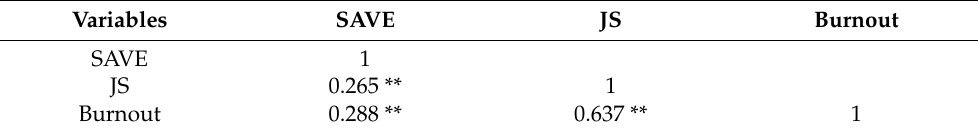
Table 3. Correlations among SAVE, JS, and burnout of dental hygienists.